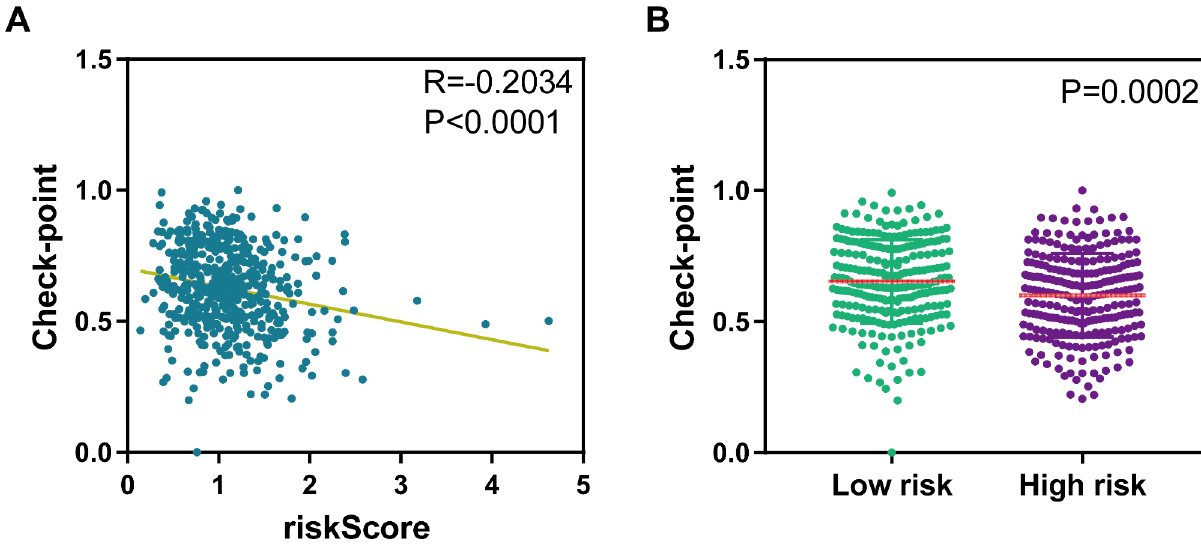
Fig. 7 The ERS-related signature shows strongly association with immune surveillance against cancer cells in HNSCC. ( A ) The biological functions of the ERS-related signature in HNSCC using GSEA analysis based on the curated gene sets c5.go.bp.v7.4.symbols. ( B ) The difference of immune cell infiltration between low- and high- risk groups based on the ERS-related signature in HNSCC using CIBERSORT algorithm. P-values are based on the Mann–Whitney test. * P < 0.05, **P < 0.01, ***P <